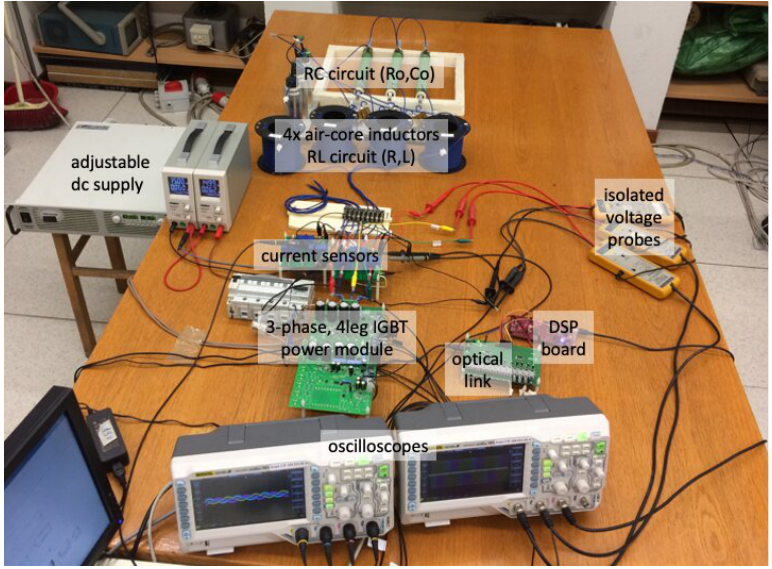
Figure 18. Experimental laboratory setup.